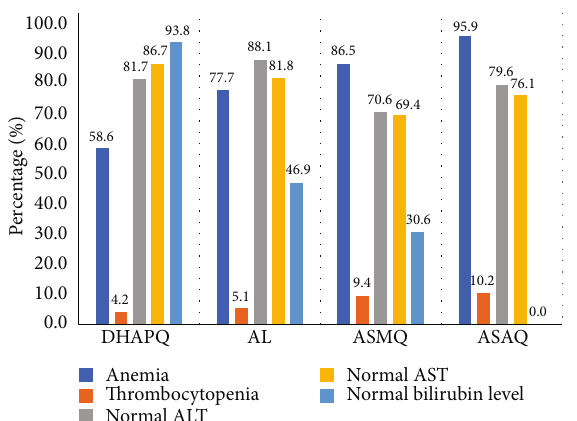
Figure 2: Prevalence of anemia, thrombocytopenia, normal liver enzyme, and bilirubin at day 7 after malaria